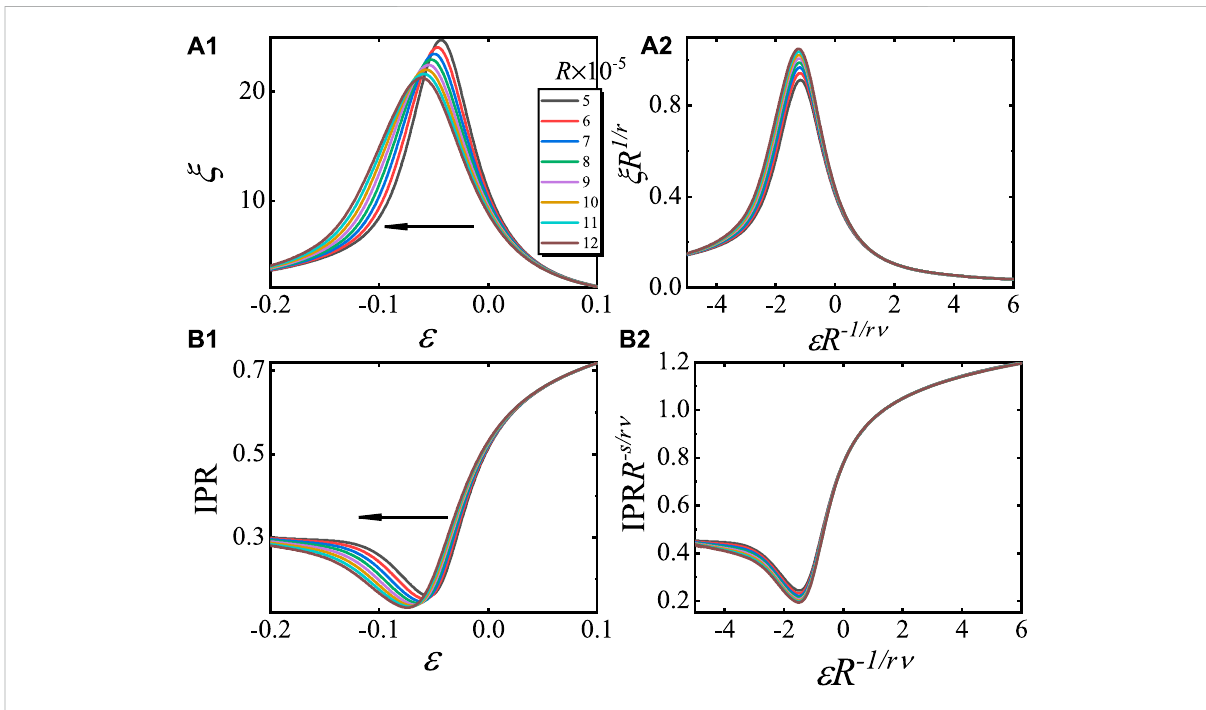
FIGURE 8 Dynamical emergence of the skin effect. (a1) Curves of ξ versus ε and (a2) the rescaled curves according to Eq. 10 for different R values. (b1) Curves of the IPR n versus ε and (b2) the rescaled curves according to Eq. 11 for different R values. Here, we use ε 0 = 1, g = 0.5, and L = 233, and the results are averaged for 10 choices of ϕ . The arrows in (a1) and (b1) point to the direction of the changing ε